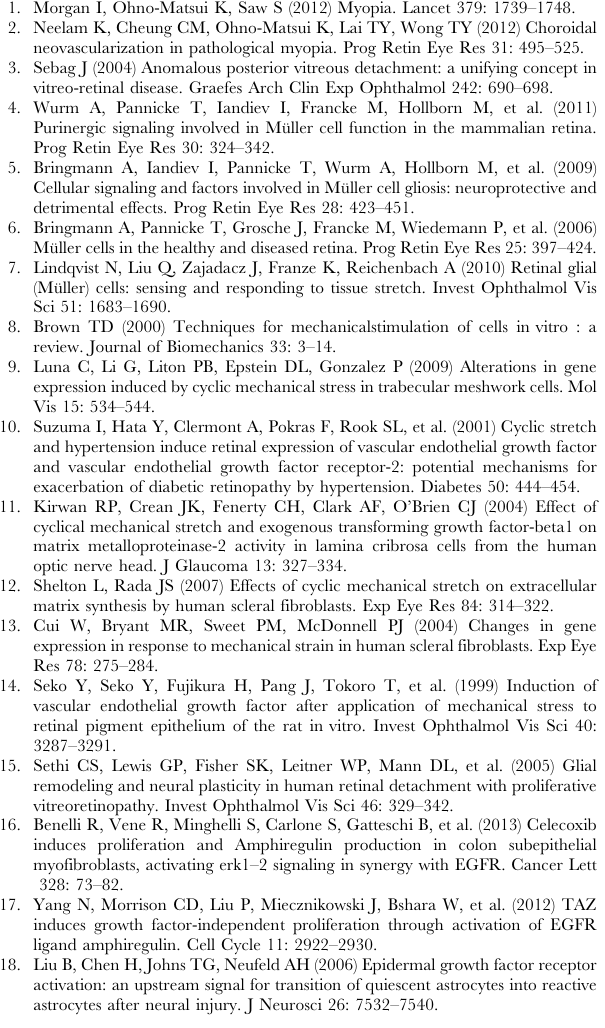
Table S4 Significantly downregulated Gene Categories after stretching for 24